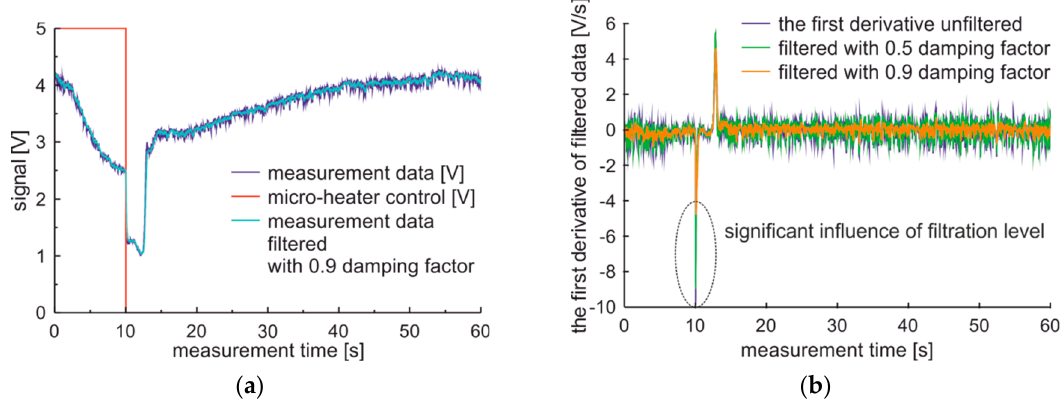
Figure 7. Measurement cycle obtained for premium-diesel fuel and results of the first derivative filtration: ( a ) Signals raw and filtered; ( b ) The first derivative of filtered signal.